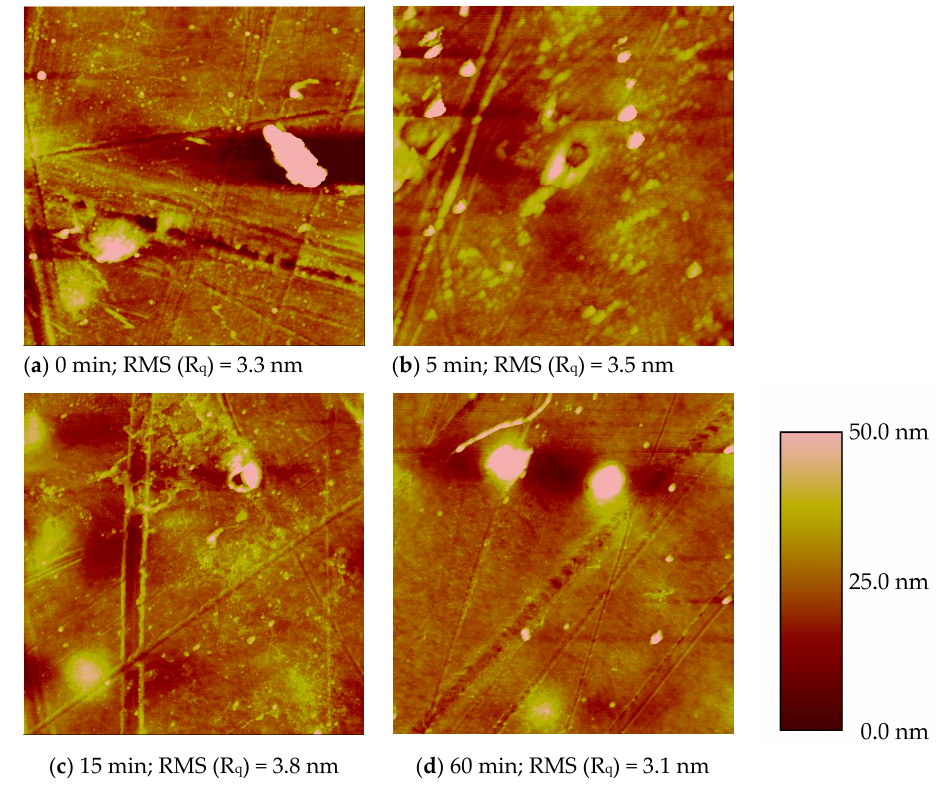
Figure 4. AFM surface topographic images after treatment of PS for ( a ) 0; ( b ) 5; ( c ) 15 and ( d ) 60 min with O atoms.